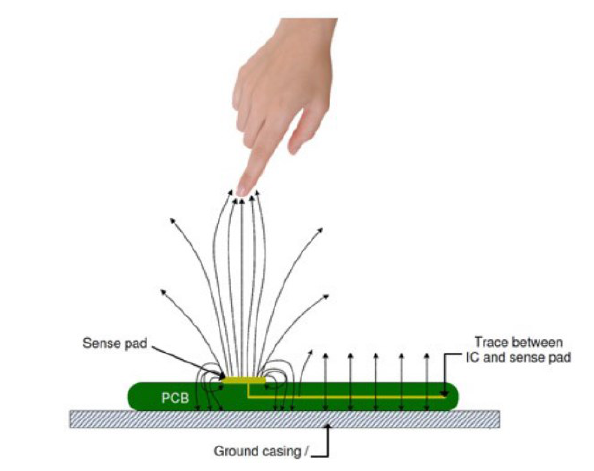
Fig. 2. Effects of electrical field